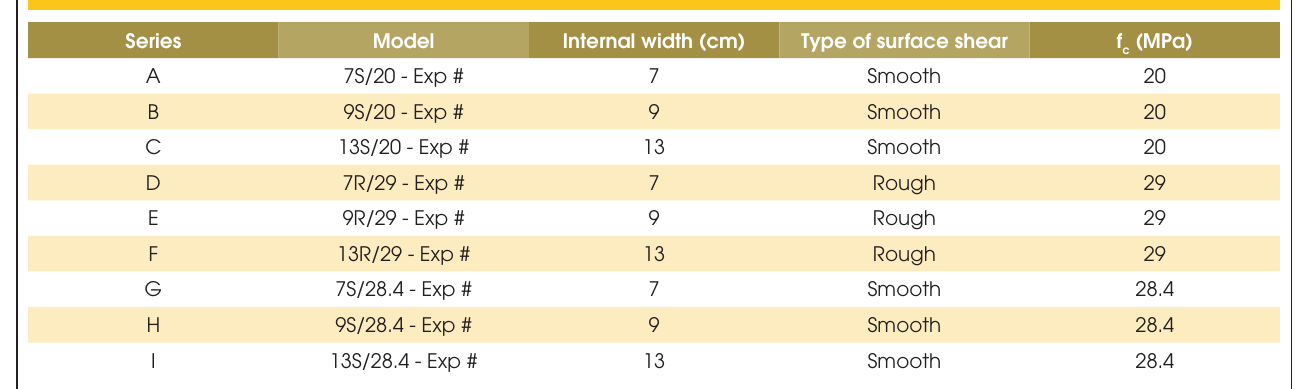
Figure 9 – Positioning of displacement transducer in direct shear test